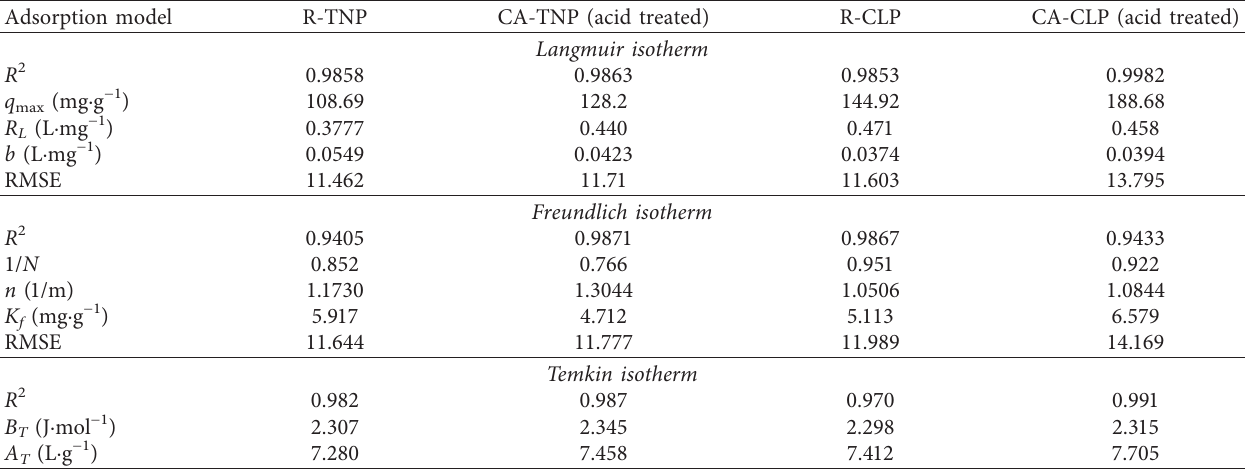
Table 3: A comparative study of isothermal parameters for the detoxification of BGD.